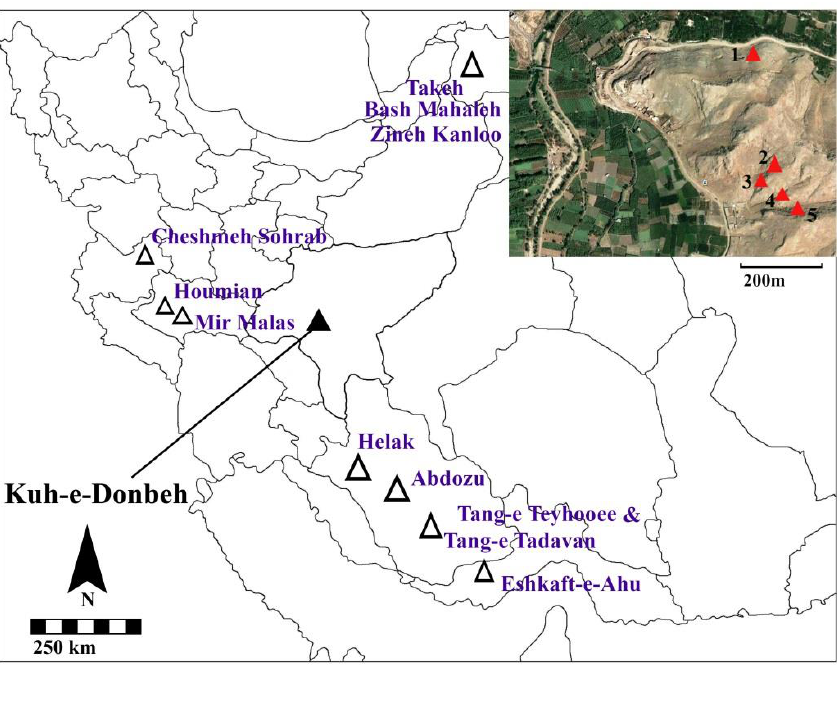
Figure 1. Map showing location of Kuh-e-Donbeh and other areas where pictograms can be found in Iran (Google Earth. www.google.com/earth/).